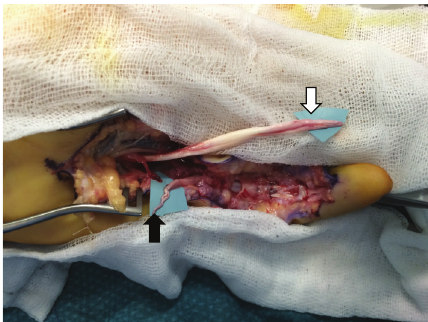
Figure 3: 6 months after